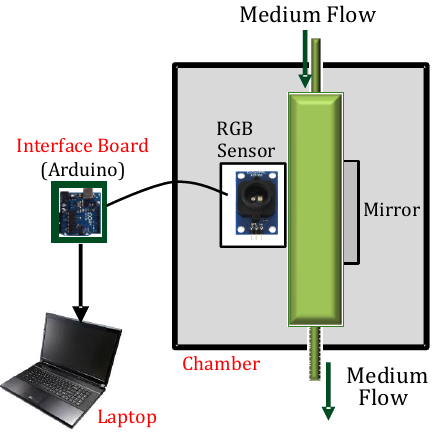
Figure 1. Sketch of the RGB sensor